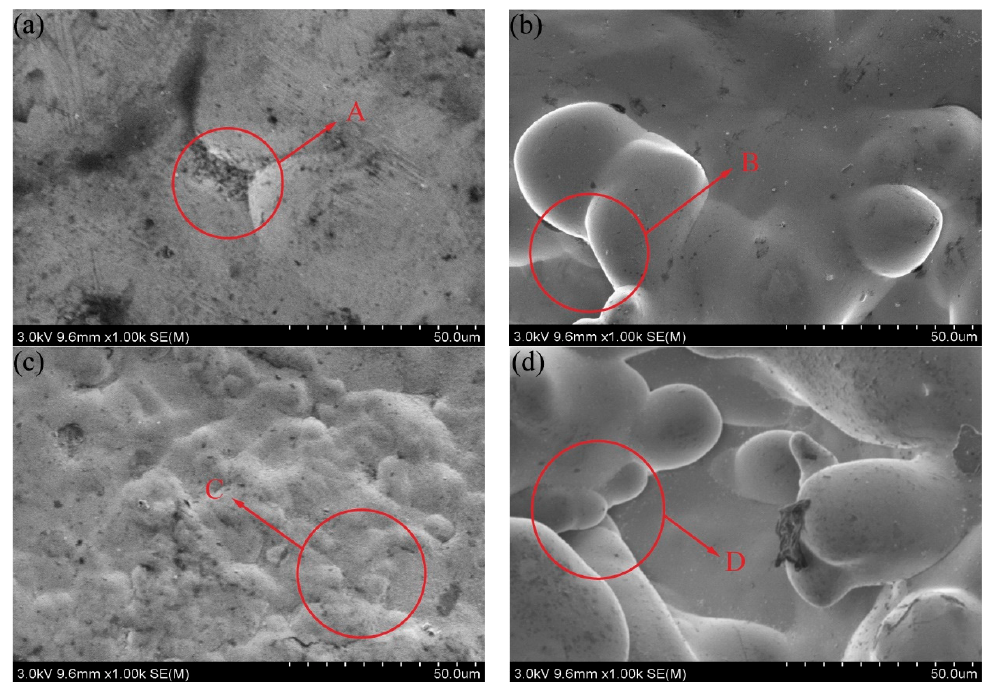
Figure 4. Surface morphologies of coatings on 45 steel substrates, prepared by scanning electrodeposition with different pretreatment processes: ( a ) Ni–P(P), ( b ) Ni–P(S), ( c ) Ni–P–SiC(P),